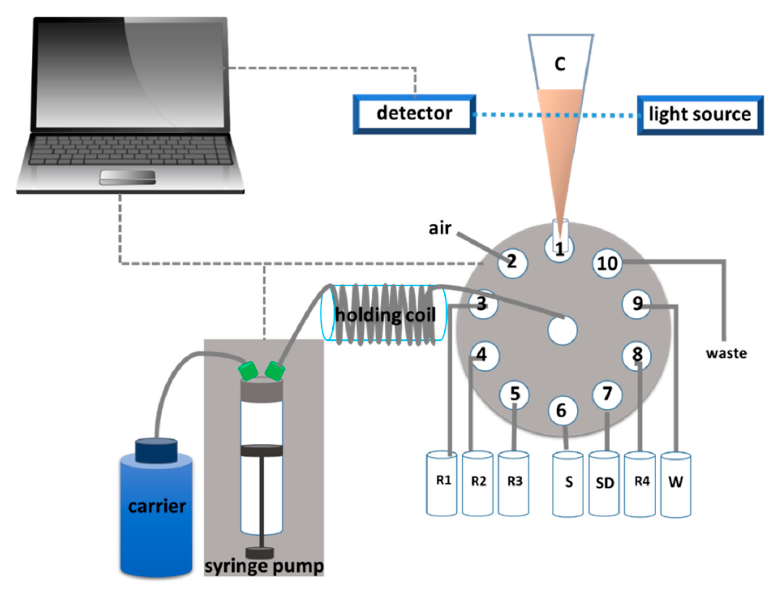
Figure 5. Schematic diagram of the sequential injection lab-at-valve